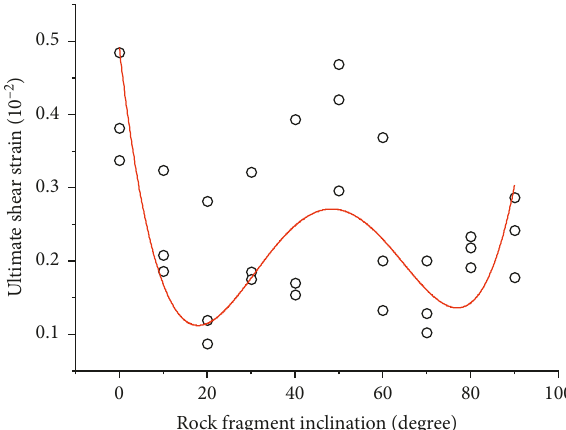
Figure 12: Relationship between ultimate shear strain and rock block